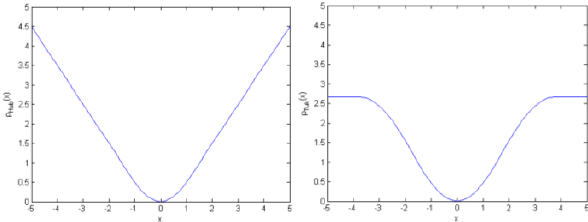
Figure 3. Huber M-estimator function with (left) and Tukey M- estimator with